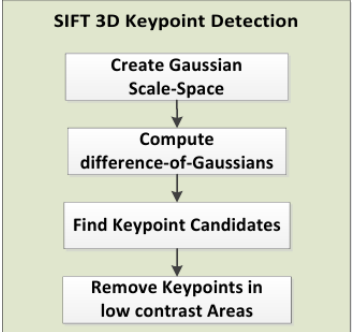
Figure 5: 3D-SIFT keypoint computation